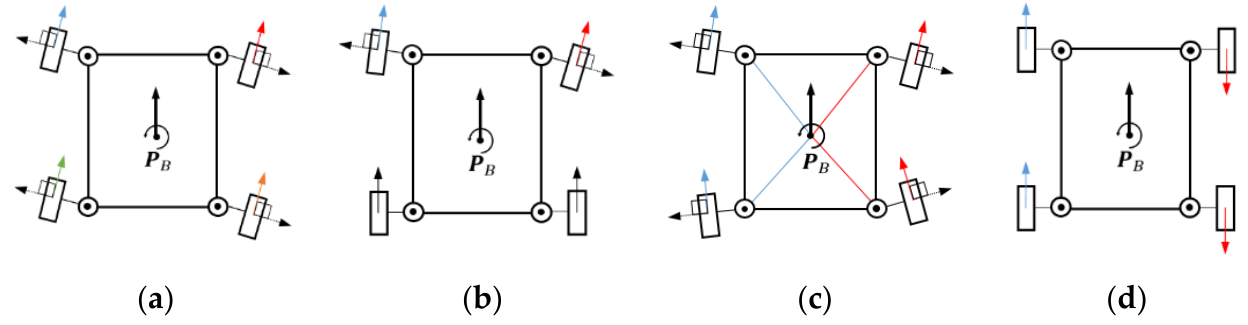
Figure 1. Steering mechanisms used for 4-wheeled mobile robots. ( a ) General explicit steering. ( b ) Car-like Ackermann steering. ( c ) Modified explicit steering. ( d ) Skid steering.